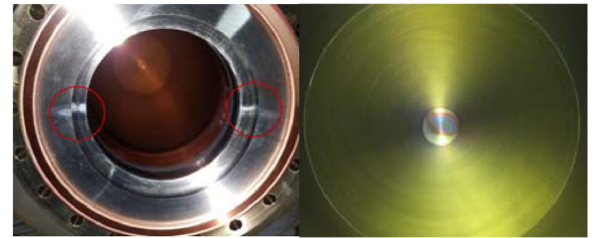
FIG. 11. Marks on the high-power beam dump surface as a result of a high-power beam operation with 20 mA beam current and 1.6 MeV kinetic energy during the 2018 run. Left: Beam dump entrance flange with marks at both sides highlighted by red circles. Right: Enlargement of the end of the